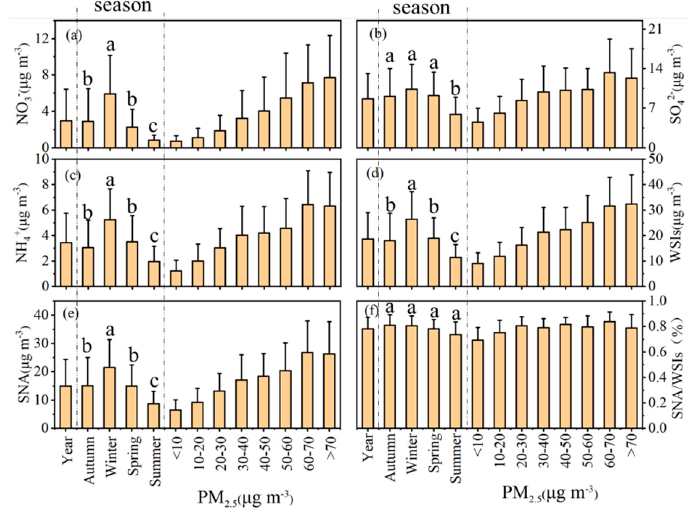
Figure 3. Mean ± SD values of ( a ) NO 3 − in PM2.5, ( b ) SO 4 2 − in PM2.5, ( c ) NH 4 + in PM2.5, ( d ) water-soluble ions (WSIs) in PM2.5, ( e ) Sulfate, nitrate and ammonium (SNA) in PM2.5, ( f ) SNA / WSIs for sampling days, different seasons and the different gradients of PM2.5 concentrations in Guiyang (the different lower cases letters above the boxes indicated that there are significant statistical differences ( p < 0.05) among seasons).